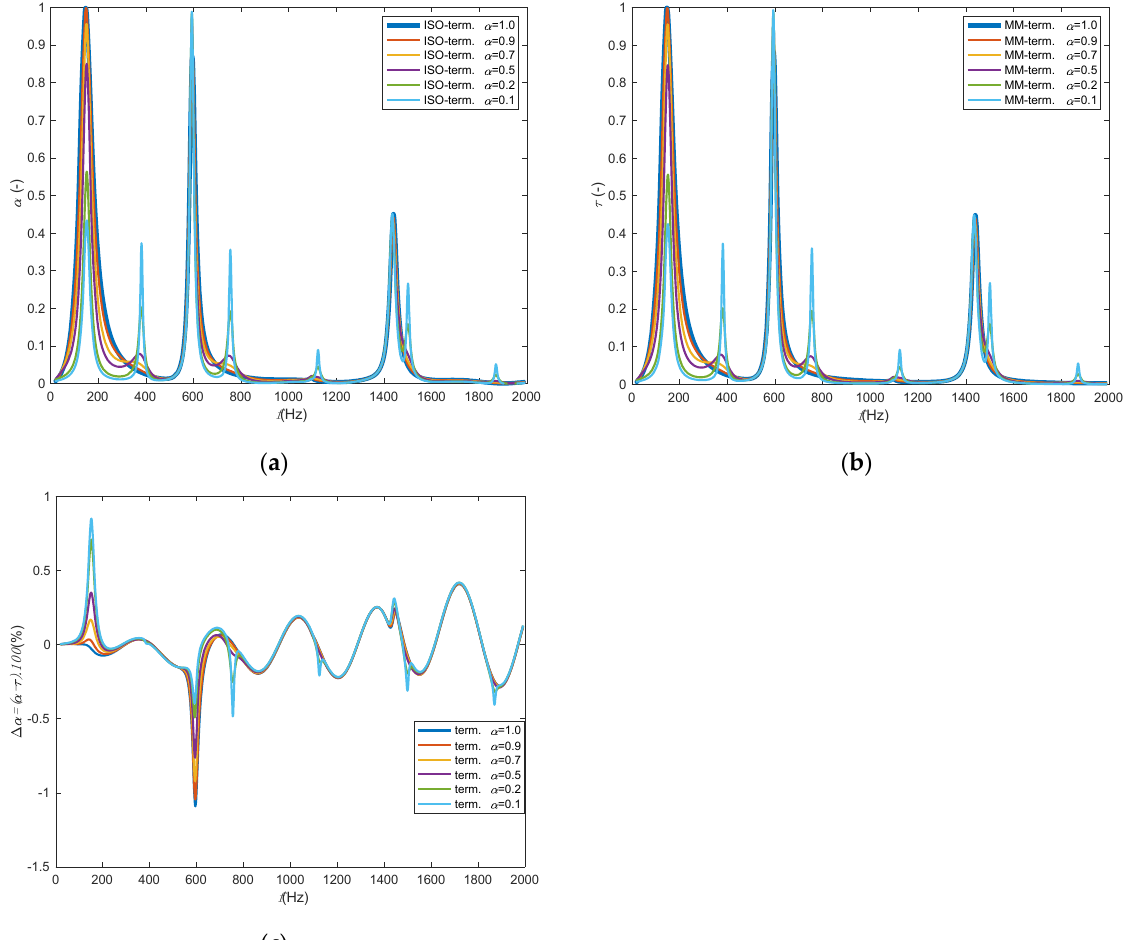
Figure 9. Normal-incidence sound absorption of a single leaf PTFE membrane determined for six different terminations (variation of termination (“term.” in the legend) absorption from α = 0.1 to 1, data were obtained from FEM). ( a ) TFM-ISO 10534-2 (“ISO” in the legend); ( b ) mobility-based method (“MM” in the legend); and ( c ) difference between sound absorption obtained by means two methods expressed in percentage.